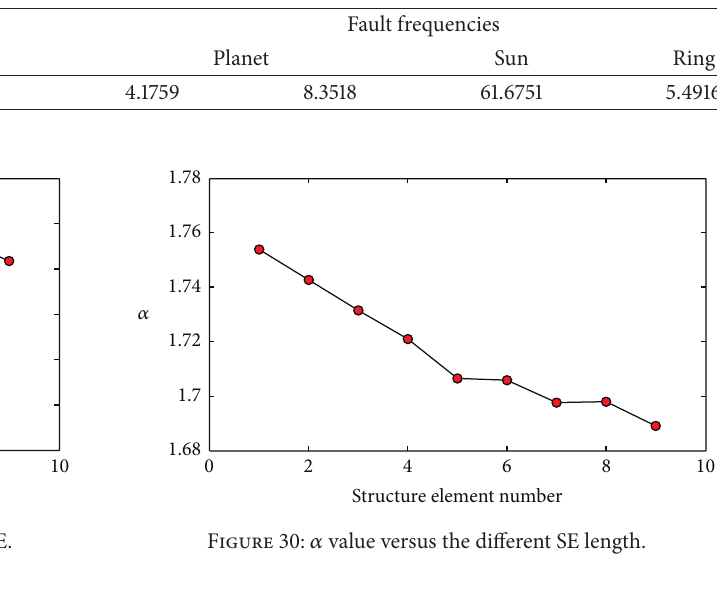
Table 4: Characteristic frequencies (Hz).